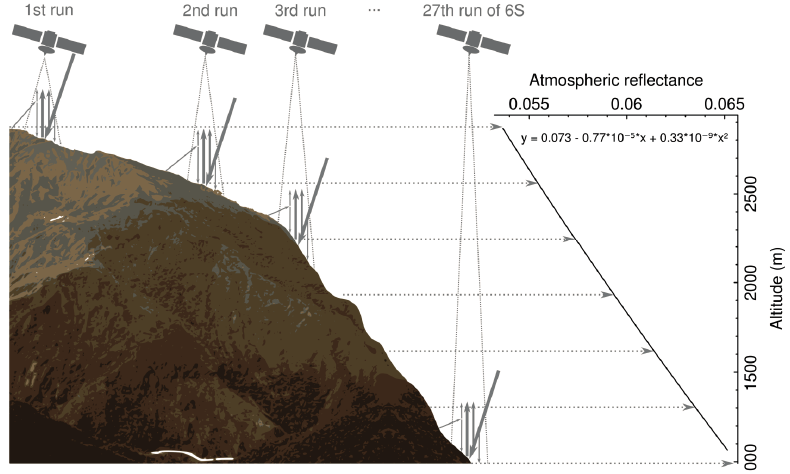
Figure 3. ( Left ) Schematic overview of the atmospheric absorption, transmittance, and reflectance calculated in the modified version of the 6S code for 27 altitudinal layers. ( Right ) As an example, we plotted the atmospheric reflectance regression line of band 1 of the Landsat ETM+ scene of 2001 according to the